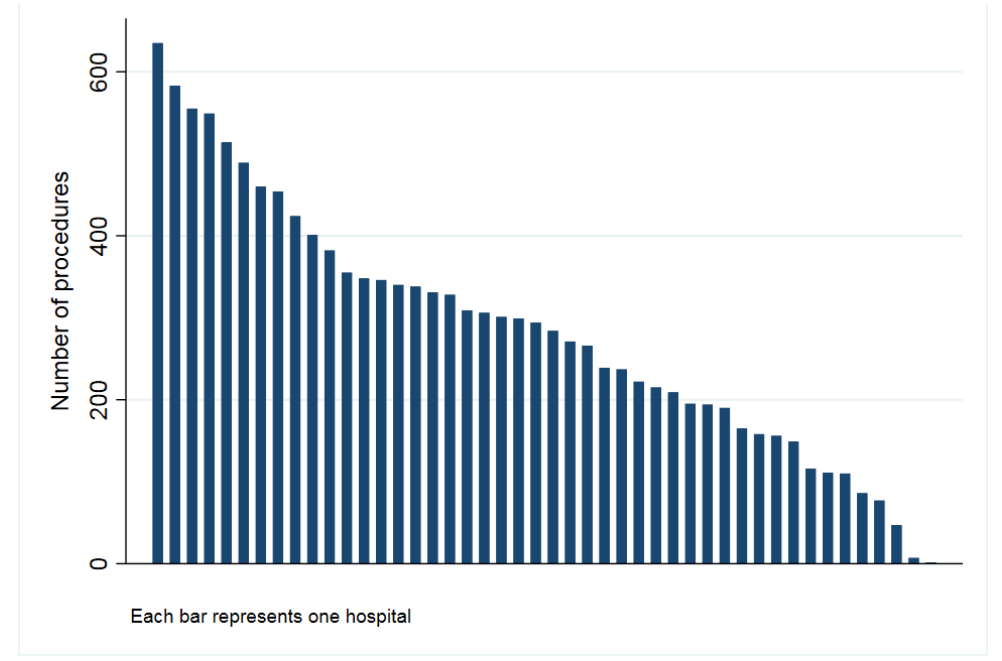
Figure 1. Number of hip procedures by hospital (2005–2016).